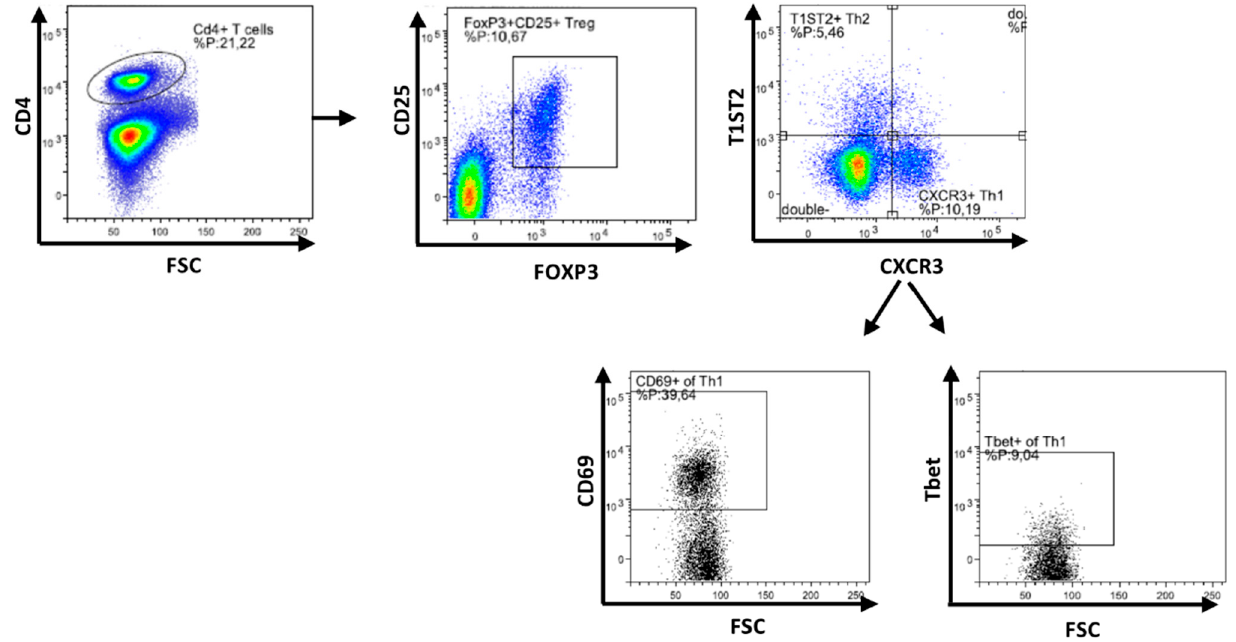
Figure 3. Flow cytometric analysis of T cell subpopulations in spleen. Gating strategy for selecting CD25 + Foxp3 + regulatory T cell (Treg), T1ST2 + Th2 cells, CXCR3 + Th1 cells and CD69 + and Tbet + cells from CXCR3 + Th1 cells.